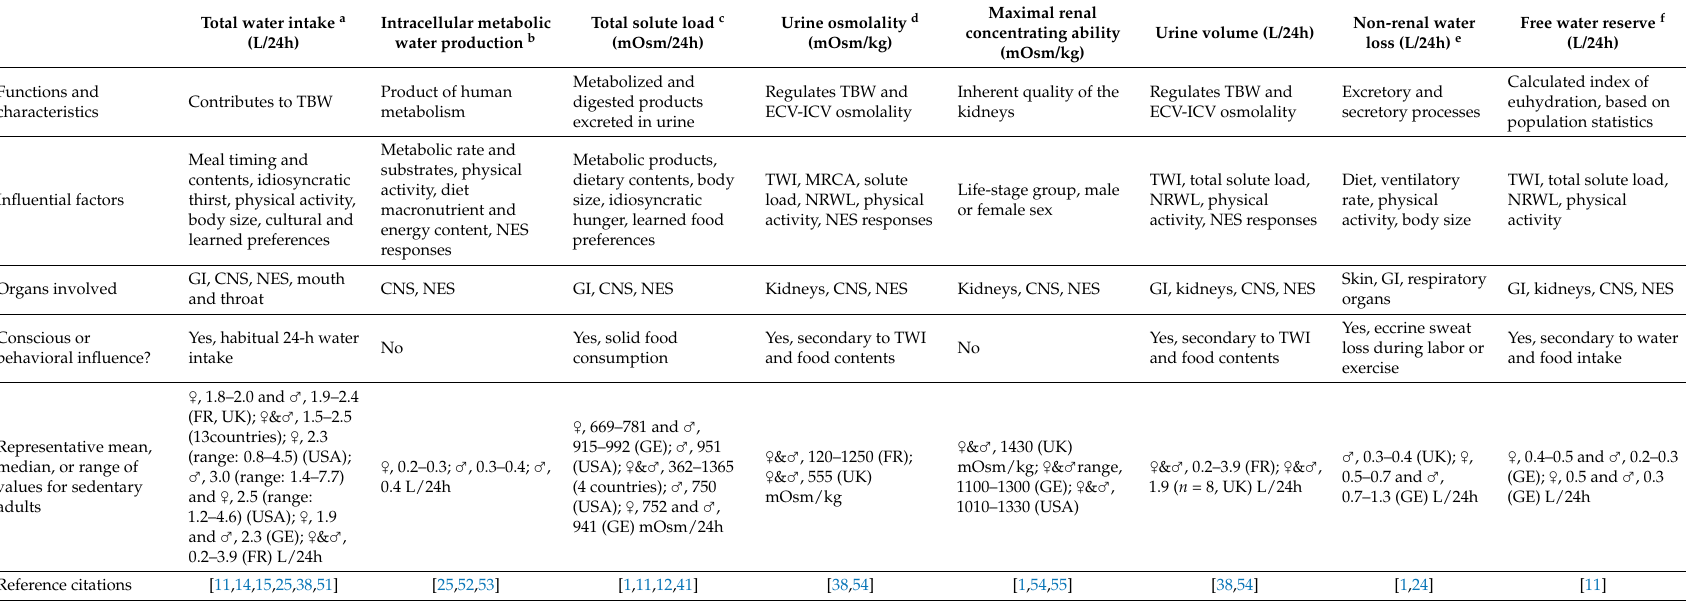
Table 3. Dietary, physiological, metabolic, and behavioral components of human 24-h water